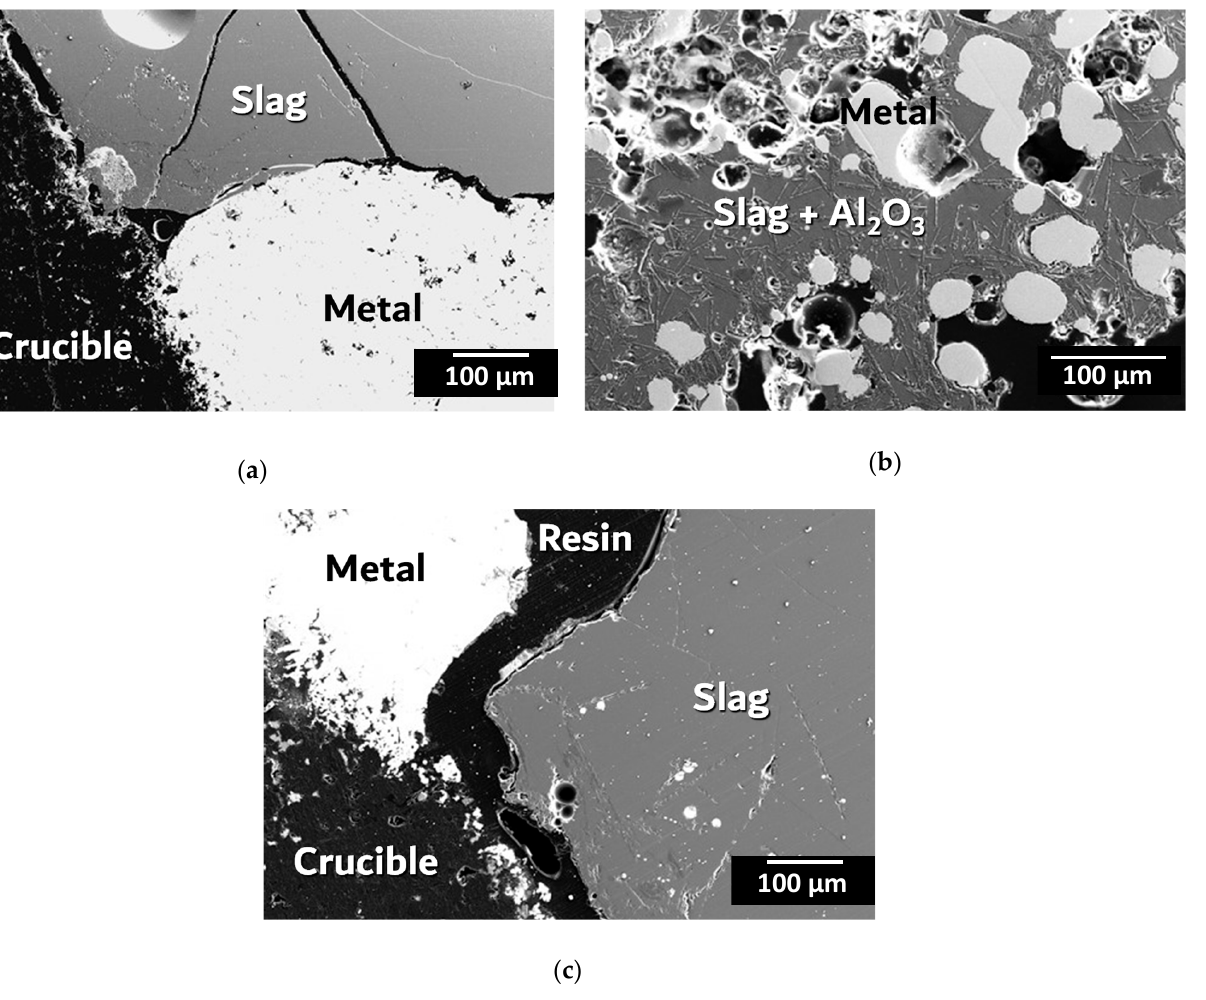
Figure 3. Microstructures of quenched samples from experiments at T = 1450 °C and t = 60 min with: ( a ) 7% carbon addition; ( b ) 14% carbon addition; and ( c ) 7% carbon + 5% LLDPE addition.